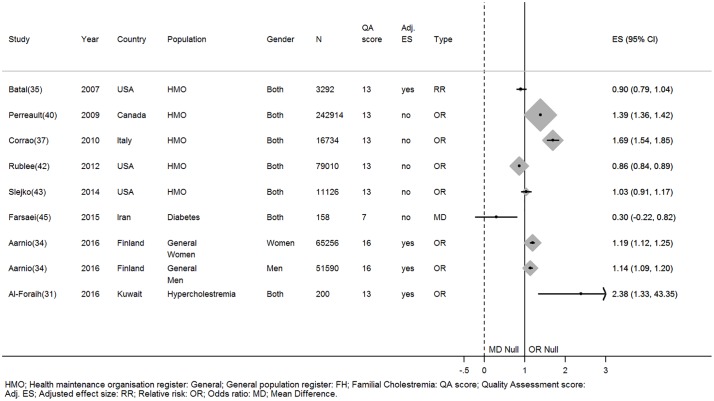
The relationship between diabetes and statin adherence.HMO: Health maintenance organisation; General: General population register; HC: Hypercholesterolemia; QA: Quality assessment; Adj. ES: Adjusted effect size; RR: Relative risk; OR: Odds ratio; MD: Mean difference.